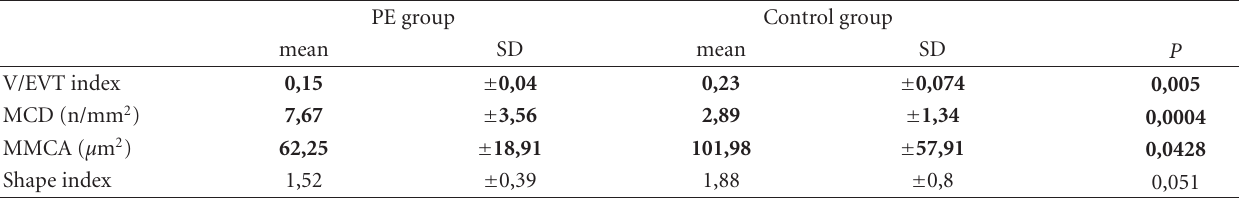
Table 2: Morphometric parameters analyzed in the study compared with Student’s t -test. V/EVT index: vascular/extravascular tissue index, MCD: mast cell density, and MMCA: mean mast cell area. The statistically significant results are in bold.